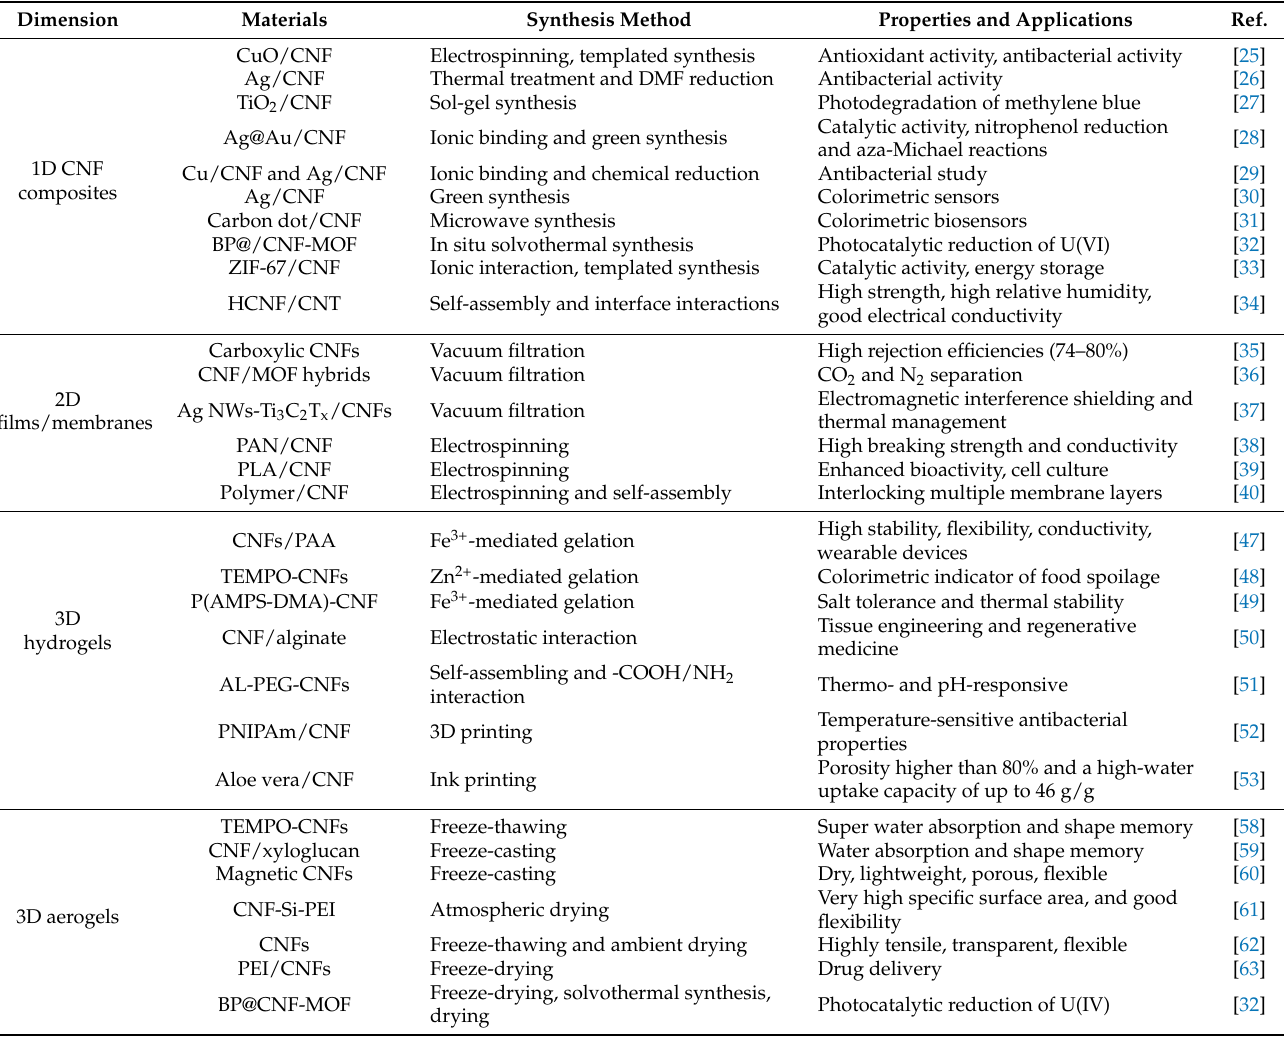
Table 1. Summary of the hybridization, synthesis, and properties of CNF-based 1D, 2D, and 3D nanomaterials. Dimension